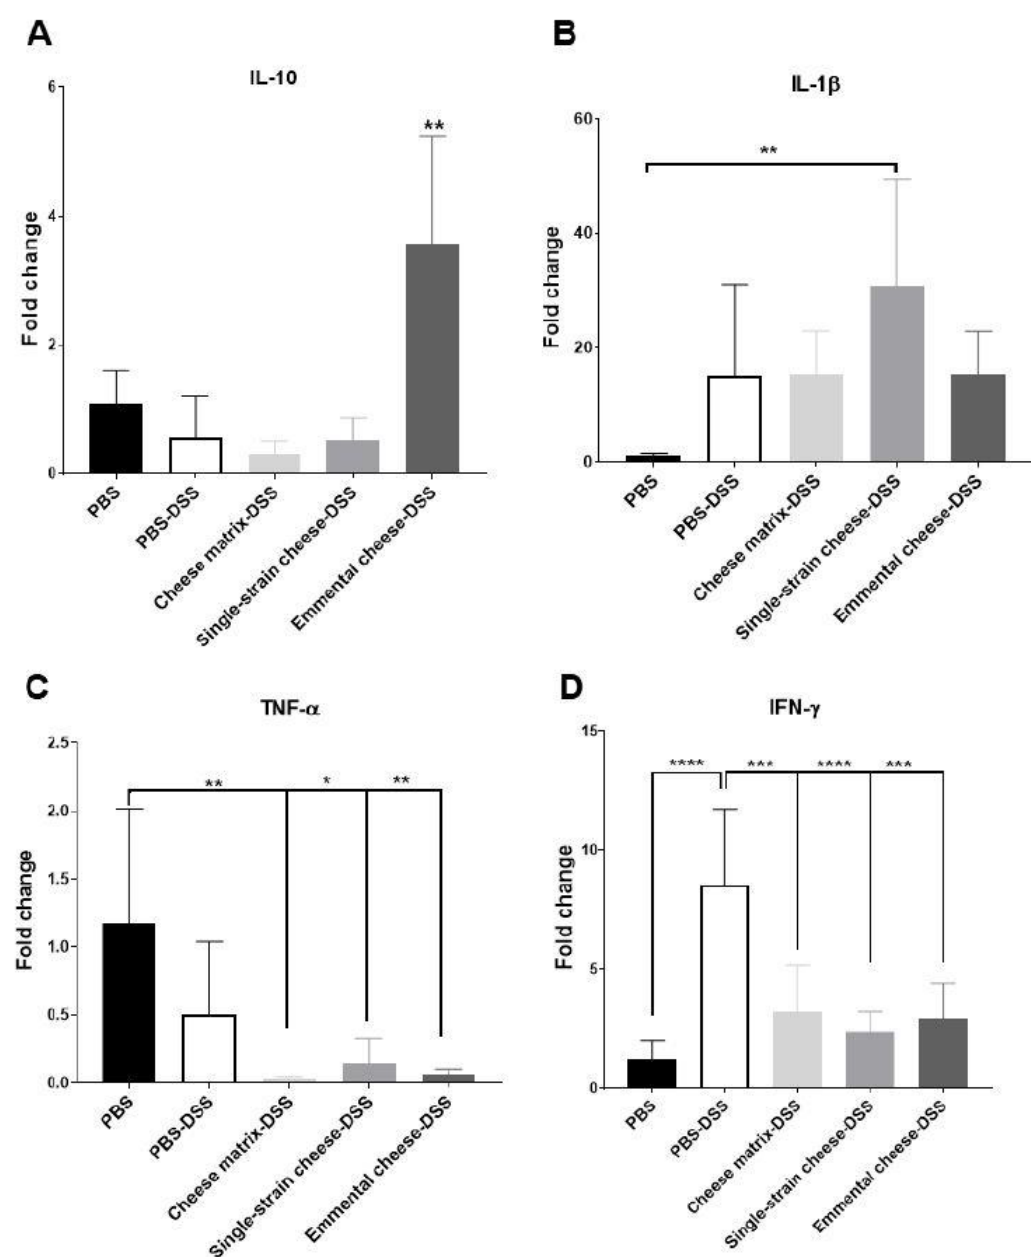
Figure 7. Impact of cheese matrix, single-strain cheese and Emmental cheese on colonic expression of cytokines genes during DSS-induced colitis. Colonic mRNA expression levels of ( A ) IL-10, ( B ) IL-1β, ( C ) TNFα and ( D ) IFNγ were determined. Data represent the mean ± SD of 6 mice per group. Groups were as follows. PBS: healthy group gavaged using PBS buffer as a sham. PBS-DSS: DSS-treated-colitis control group gavaged using PBS buffer as a sham. Cheese matrix-DSS: DSS-treated group gavaged using a germ-free dairy matrix. Single-strain cheese-DSS: DSS-treated group gavaged using an experimental single-strain cheese containing P. freudenreichii CIRM-BIA 129 as a sole bacterium. Emmental-DSS: DSS-treated group gavaged using an industrial Emmental cheese produced using P. freudenreichii CIRM-BIA 129 as a ripening starter. Multiple comparisons were performed, * p < 0.05, ** p < 0.01, *** p < 0.001 **** p < 0.0001.